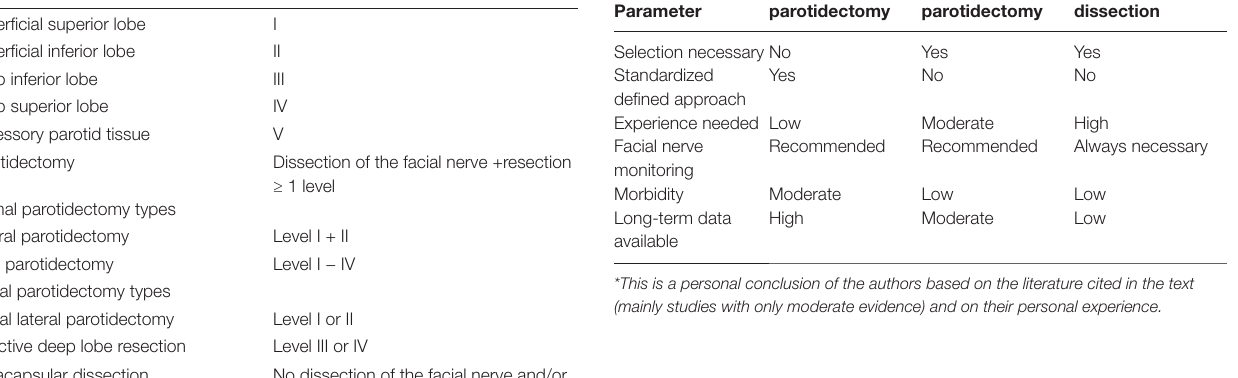
TABle 6 | Comparison of different surgical techniques to approach to superficial lobe of the parotid gland*